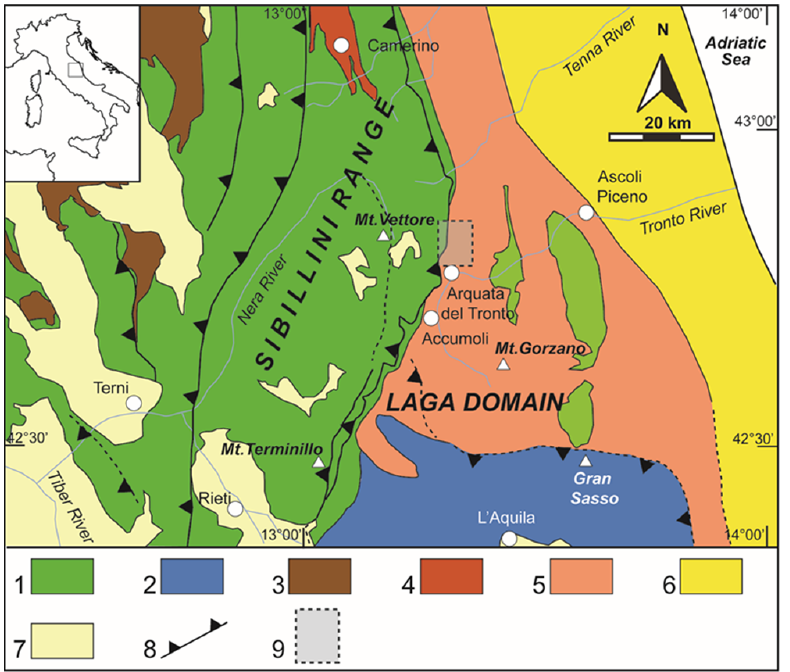
Figure 1. Geological sketch map of the study area (after [57]). Legend: 1. Calcareous, marly-calcareous and marly basin sequences of the Umbria-Marche-Sabina Apennines (Upper Trias—Miocene p.p.); 2. Calcareous and marly-calcareous platform-slope sequence of the Latium-Abruzzi Apennines (Upper Trias—Miocene p.p.); 3. Miocene siliciclastic turbiditic deposits (Burdigalian p.p.—Tortonian p.p.); 4. Miocene siliciclastic deposits (Serravallian p.p.—Messinian p.p.); 5. Miocene siliciclastic deposits fo the Laga sequence (Messinian p.p.); 6. Pliocene to Pleistocene marine and continental peri-Adriatic deposits; 7. Post-orogenic marine and continental deposits (Piocene to Quaternary); 8. Main thrust front; 9. Study area.